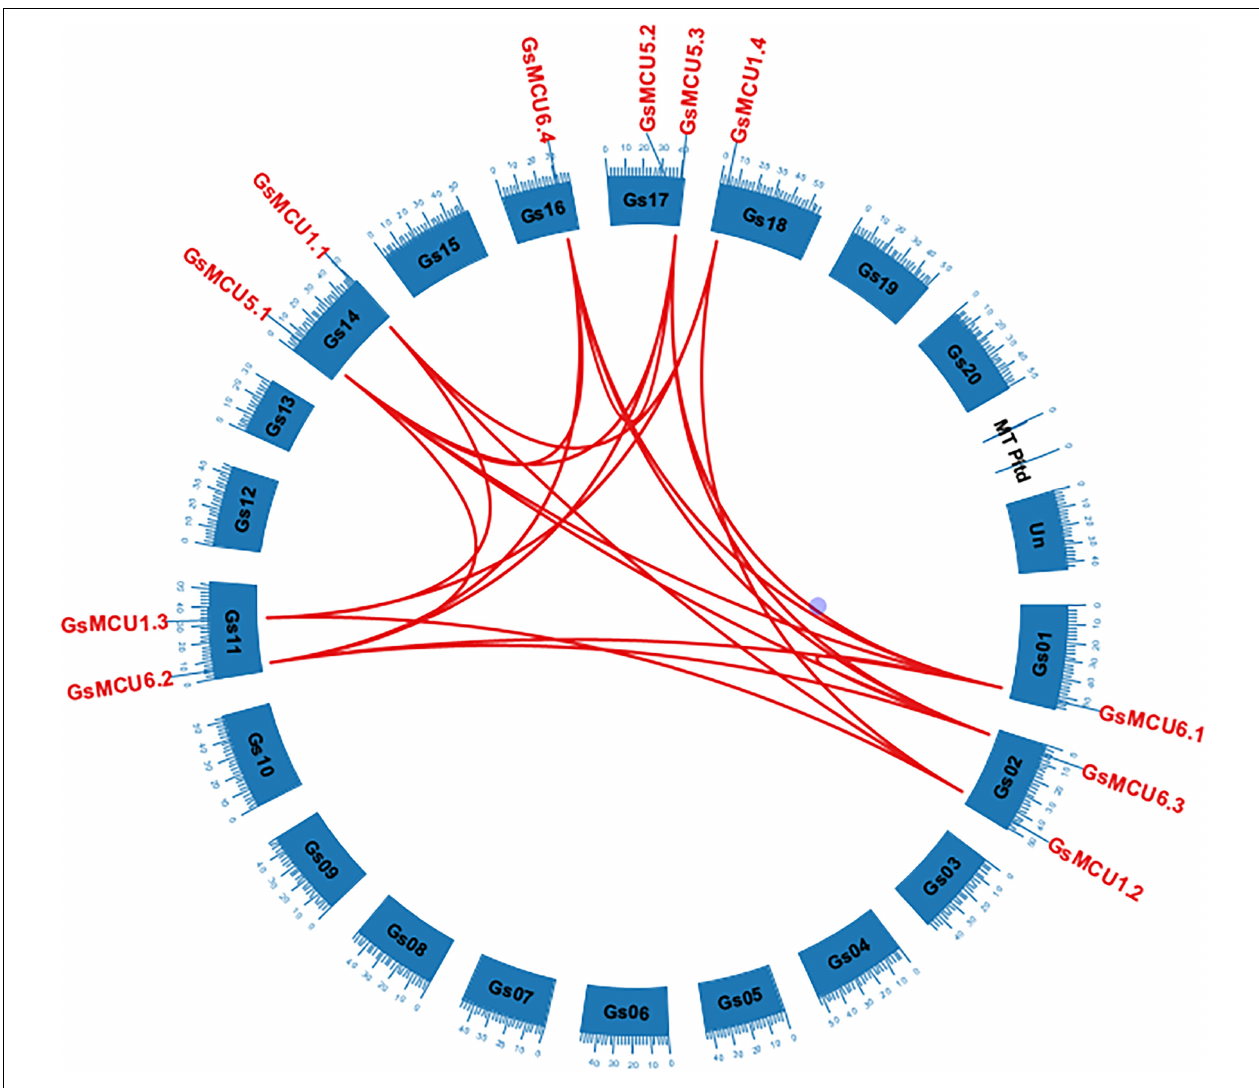
FIGURE 2 | Distribution and duplication of the MCU genes in the wild soybean genome. Duplicated genes among the GsMCUs were downloaded from the PGDD database and are indicated by red lines.